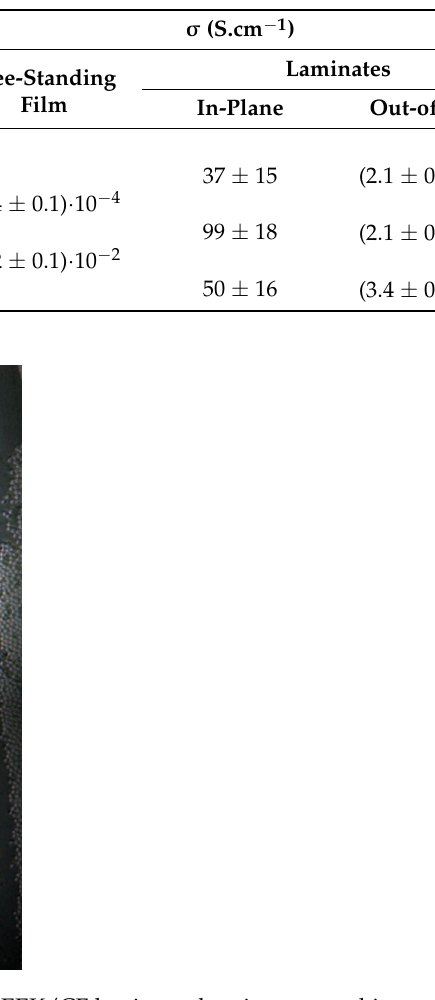
Figure 9. Optical microscopy image of the PEEK/CF laminate showing a very thin outer layer at specific locations (marked by a yellow arrow). Table 3. In-plane and out-of-plane conductivity values of all laminates. Conductivity values for the free-standing nanocomposite films are also included for comparison [31].